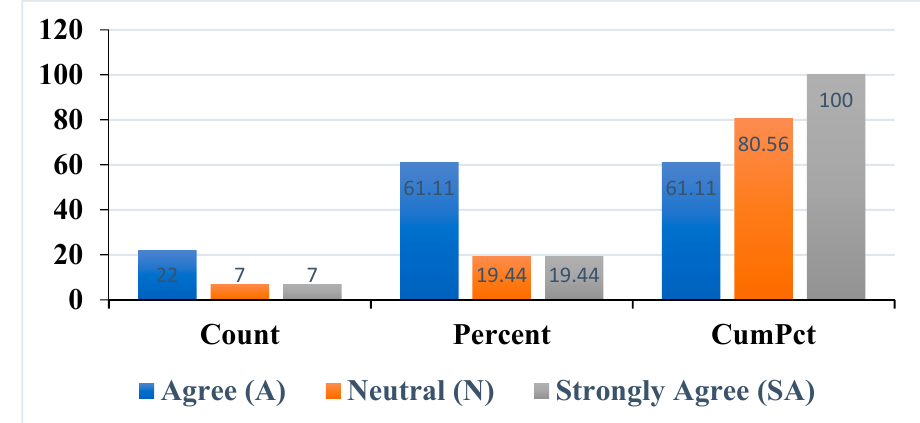
Figure 1. Frequency analysis .